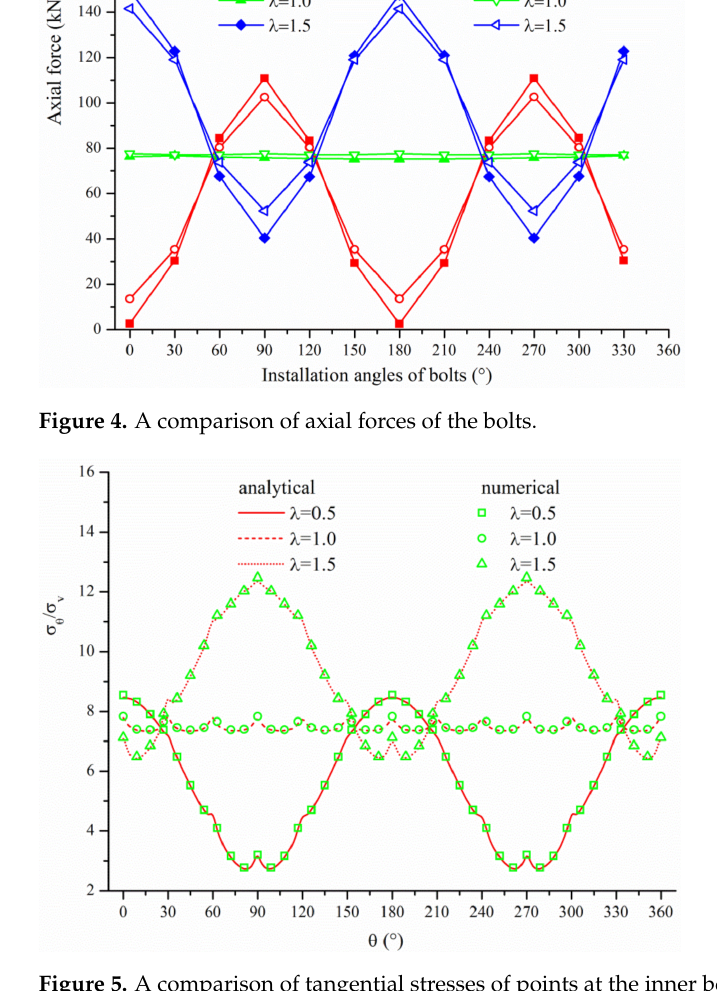
Figure 5. A comparison of tangential stresses of points at the inner boundary of the